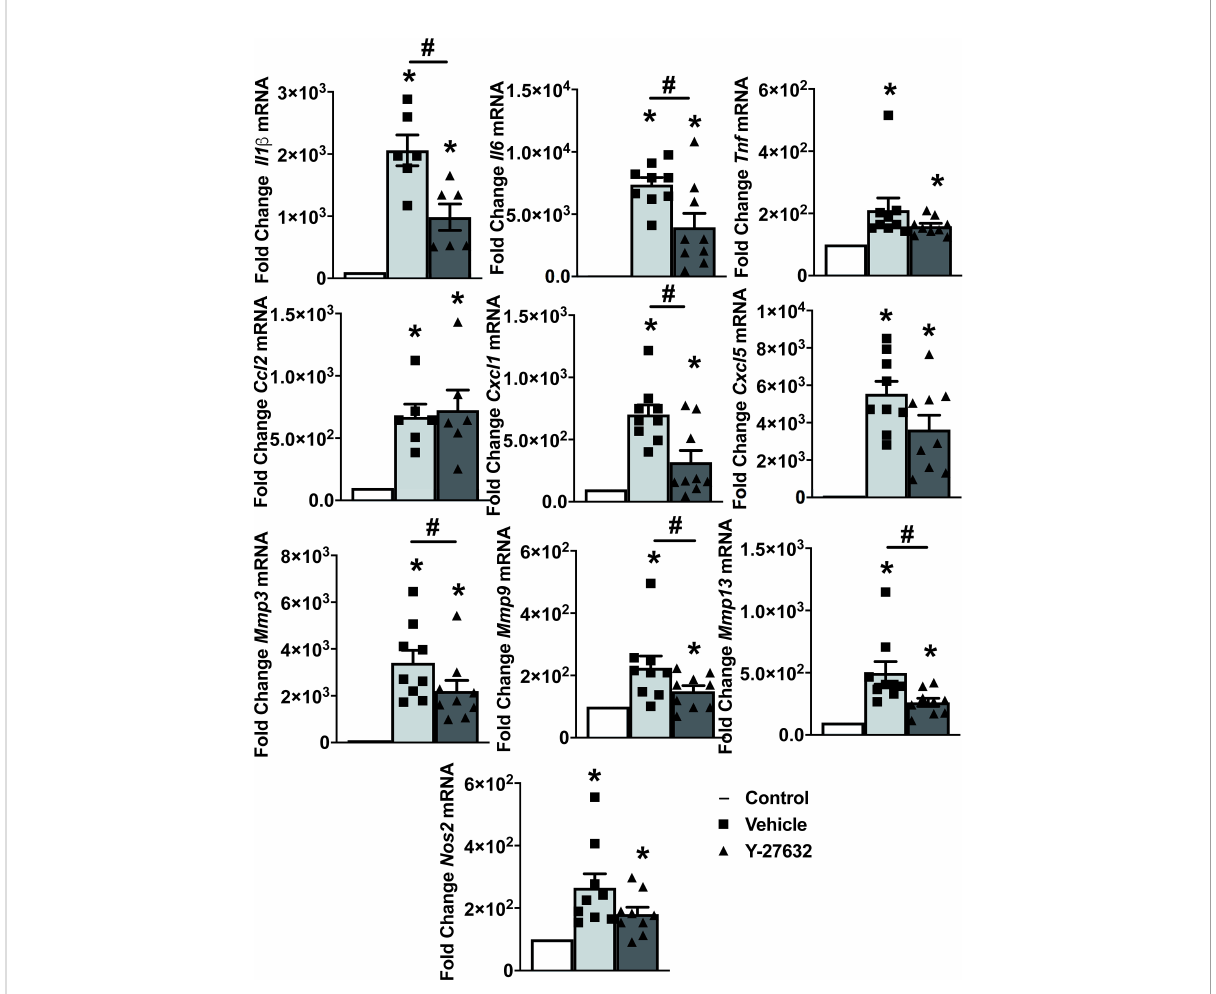
FIGURE 4 ROCK inhibition with Y-27632 diminished the expression of in fl ammatory mediators and metalloproteinases. Comparison of cytokines (Il-1 b , Il- 6, TNF a ), chemokines (Ccl2, Cxcl1, Cxcl5), metalloproteinases (Mmp3, Mmp9, Mmp13), and Nos2 mRNA expression in the joints of non-arthritic control mice and arthritic mice treated with Y-27632 or vehicle. Values represent Mean ± SEM from 6-9 mice per group. *p < 0.05 for the comparison with the non-arthritic control mice and # < 0.05 for comparison between the two groups of arthritic mice (Mann-Whitney